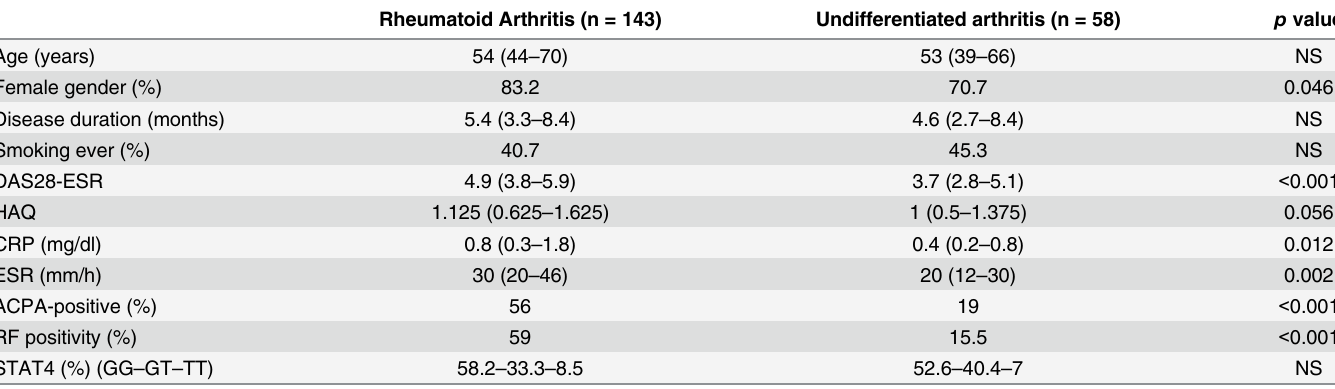
Table 1. Baseline characteristics of patients with early